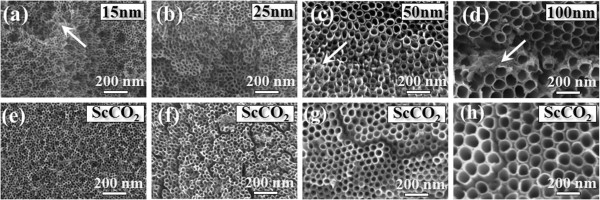
SEM images of self-organized TiO2 nanotubes with different diameters. The nanotubes are in the range of 15 to 100 nm before (a to d) and after (e to h) the ScCO2 treatment. Disordered Ti(OH)4 precipitates are indicated by white arrows.